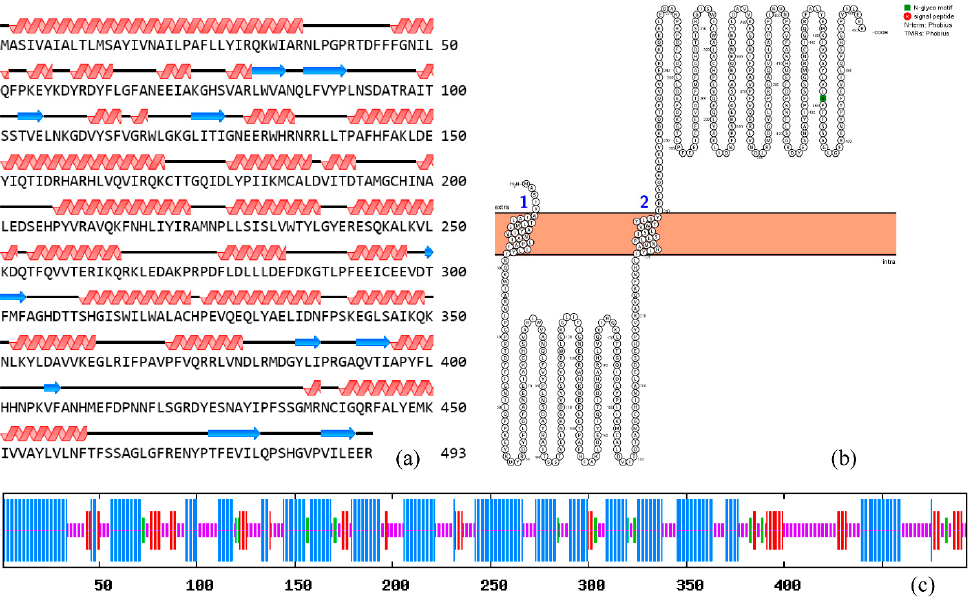
Figure 3. Structural analysis of Bx-cyp29A3 . ( a ) Protein secondary structure prediction based on position-specific scoring matrices of Bx-cyp29A3 ; ( b ) Topological analysis of Bx-cyp29A3 . Numbers represent sites of transmembrane structures; ( c ) . SOPMA—Protein secondary structure prediction peak, blue: Alpha helix; Green: Beta turn; Yellow: Random coil; Red: Extended strand. The tertiary structural homology model of Bx-cyp29A3 by SWISS-MODEL is shown